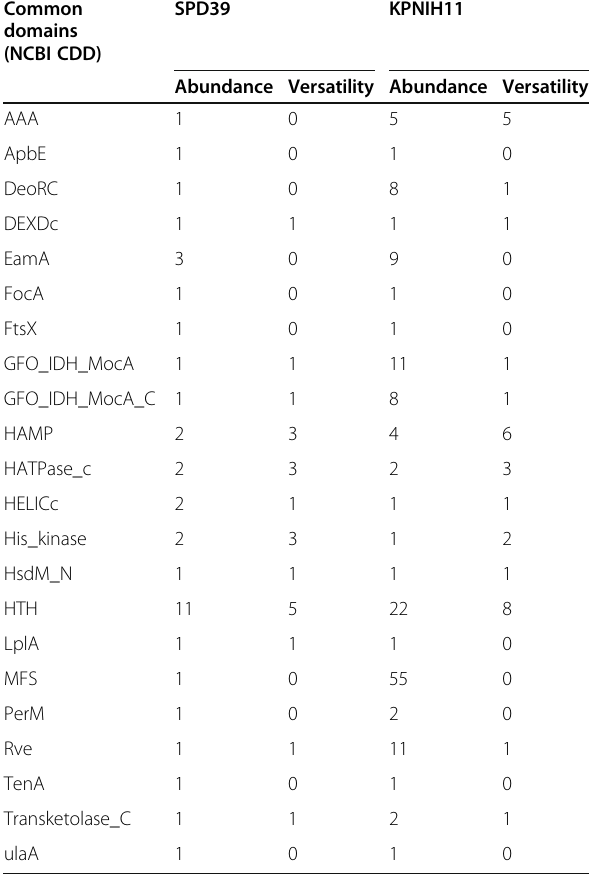
Table 1 List of shared domains with their